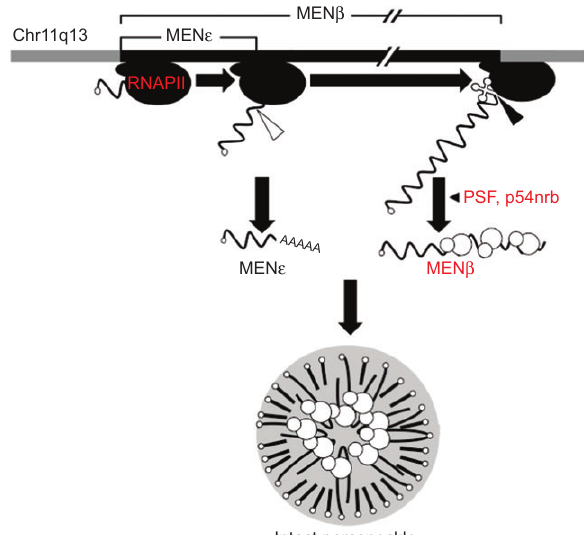
Figure 2 Model of intact paraspeckle